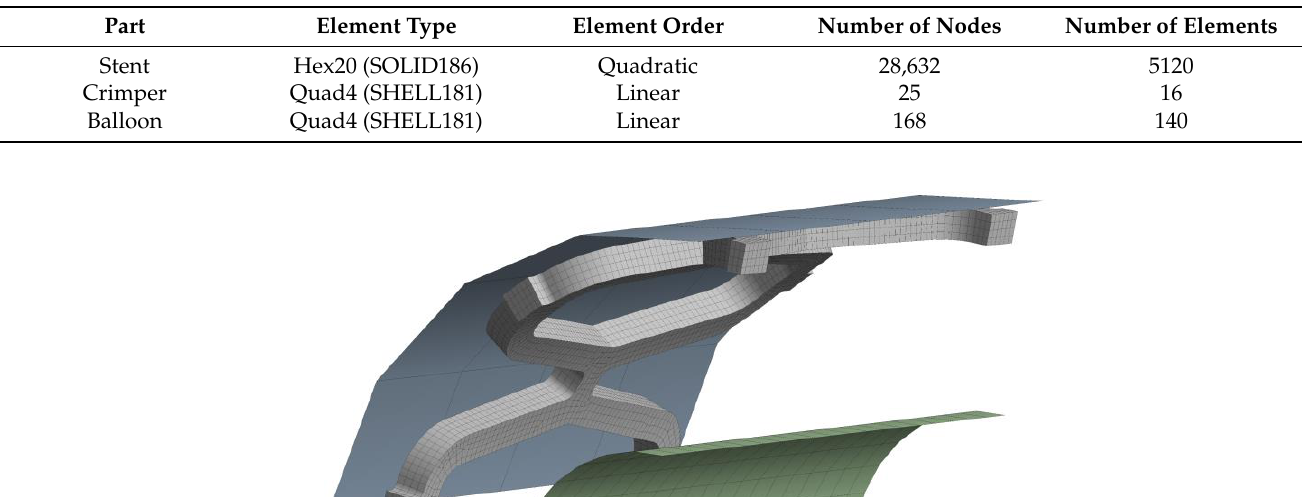
Table 3. Finite element mesh properties for numerical analysis.